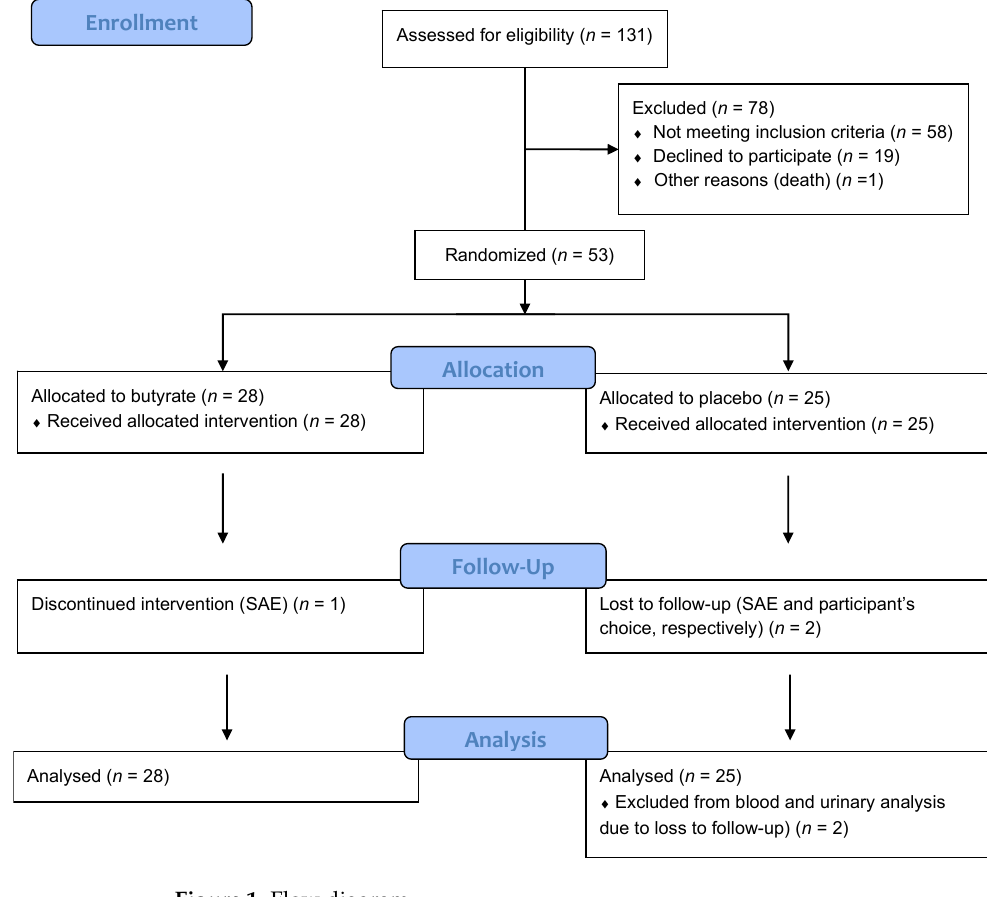
Figure 1. Flow diagram. Table 1. Baseline